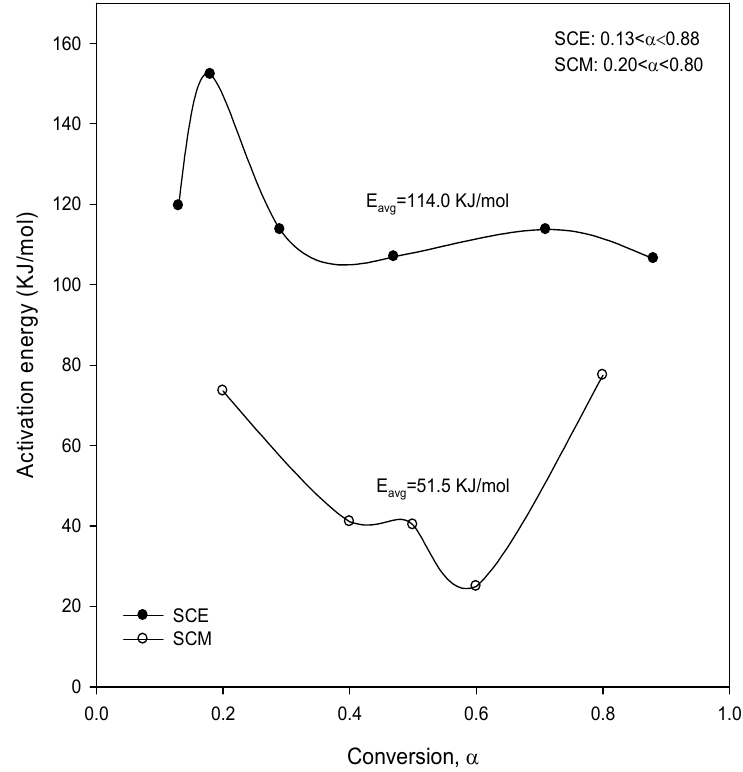
Figure 7. Activation energy upon conversion obtained from Equation (12) for SCE and